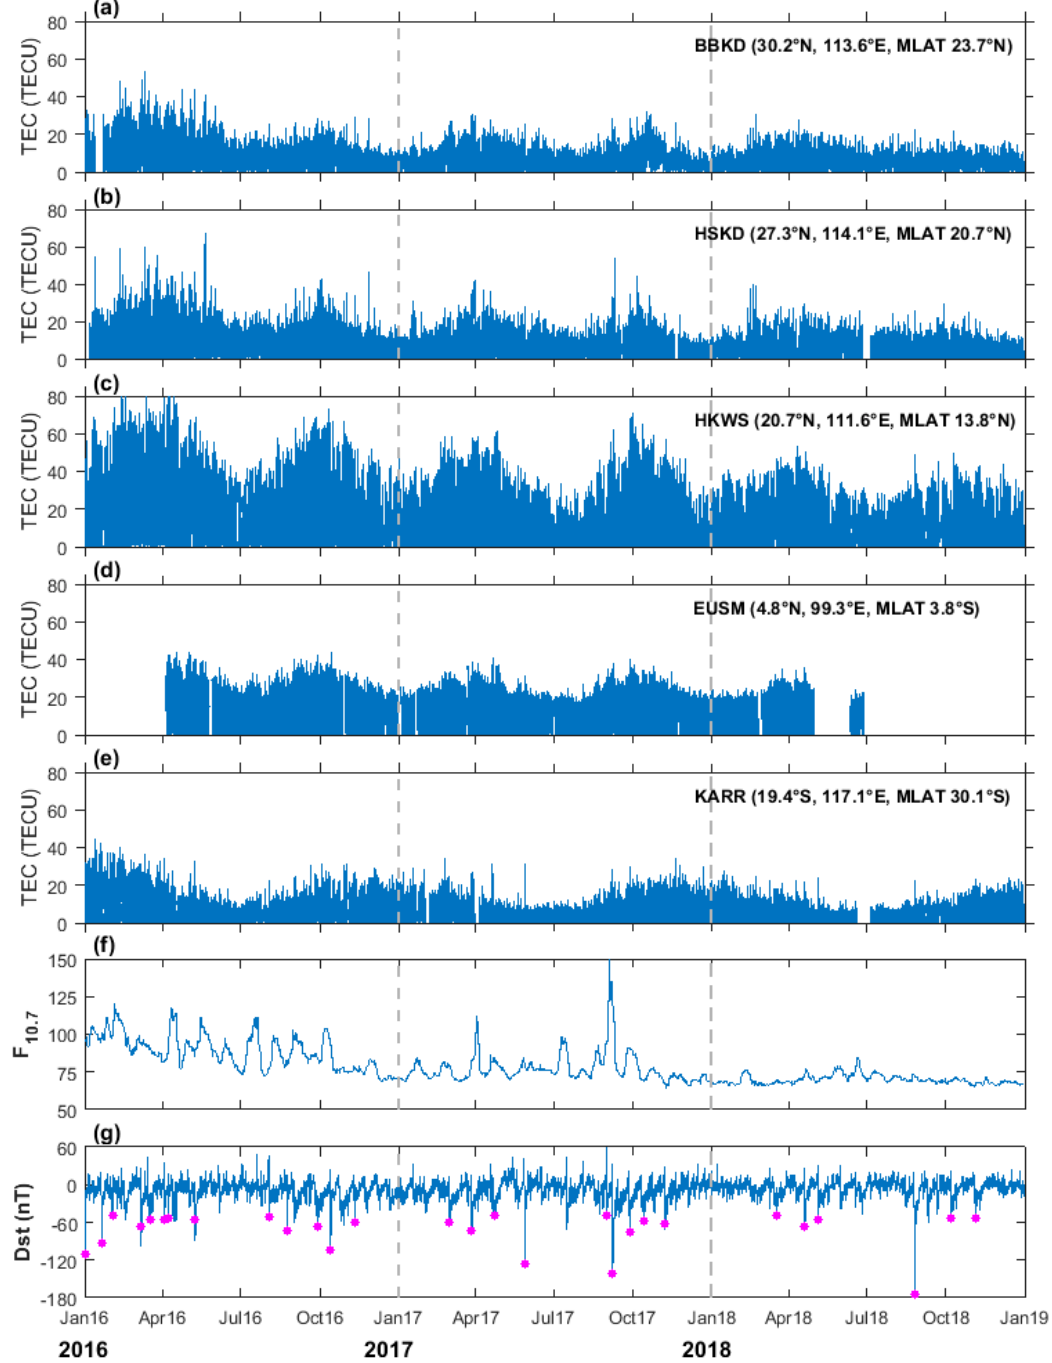
Figure 2. The time series of total electron content (TEC) over ( a – e ) BBKD, HSKD, HKWS, EUSM, and KARR, respectively. ( f ) The 10.7 cm solar radio flux (F10.7) and ( g ) the ring current index (Dst) during 2016–2018 are shown in the bottom panels. The grey vertical dashed lines separate the end of one year from the beginning of another year while the magenta solid shapes indicate Dst ≤ − 50 nT under this study. The shown coordinates in brackets are the IPP geographic latitudes, longitudes, and geomagnetic latitudes, respectively, over the stations.